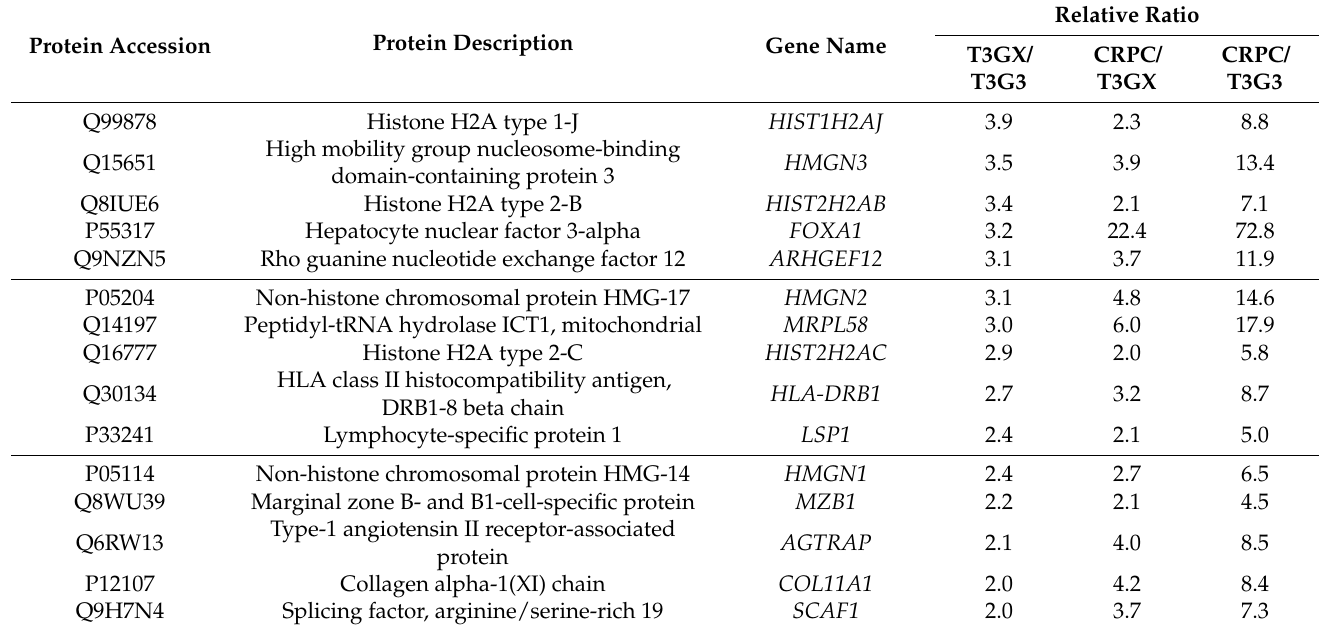
Table 1. Protein list of group 1, indicating a continuous increase from T3G3 to CRPC